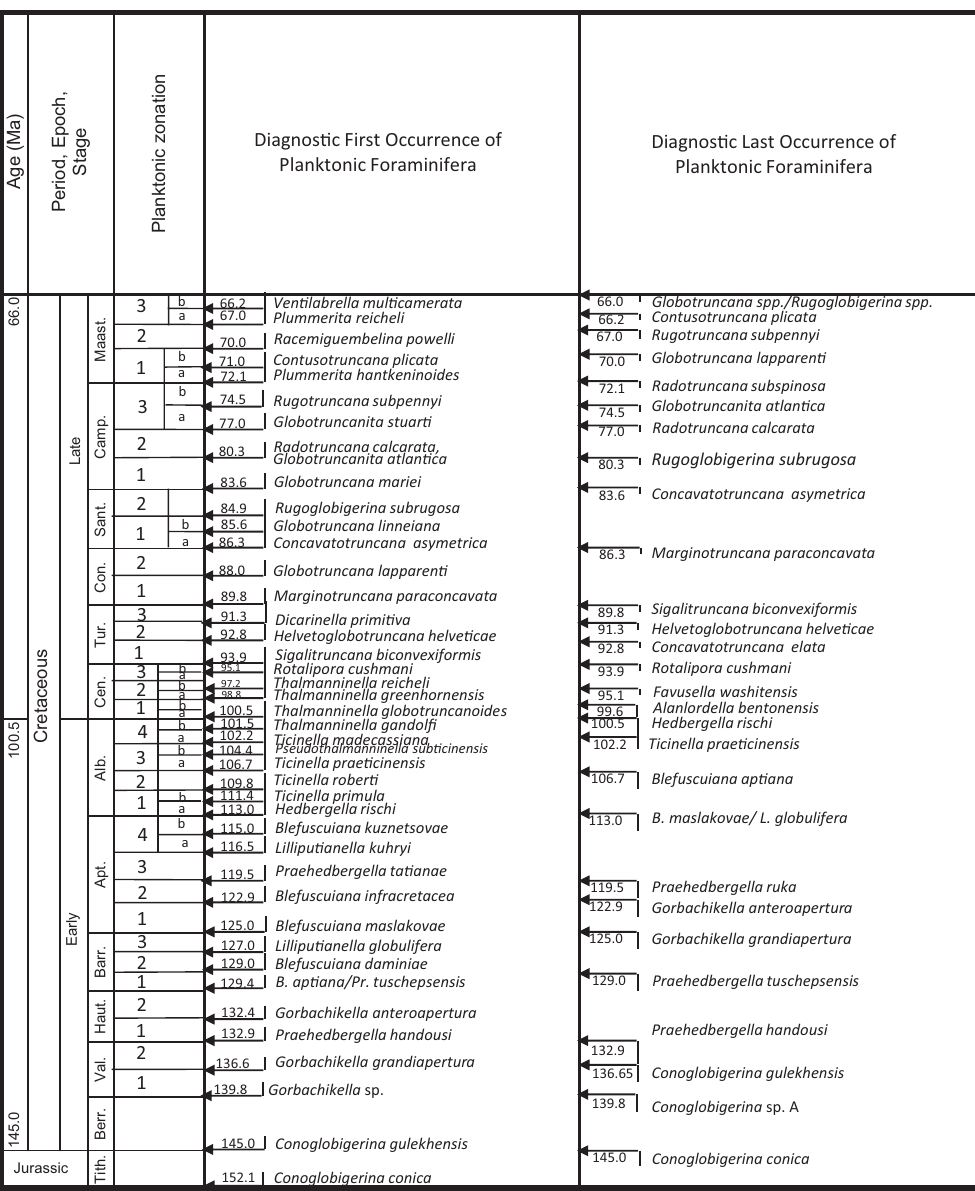
of the Meratus Mountains, an uplifted accretionary collision complex that records suturing of The diagnostic first and last occurrences of Cretaceous planktonic East Java–West Sulawesi to the Sundaland margin during the mid-Cretaceous (see Fig. 3). The foraminiferal species, calibrated against uplifted complex now forms the eastern boundary of the Barito Basin, South Kalimantan, Indonesia the most recent biostratigraphic time (see [60]). scale and radio-isotope data (after BouDagher-Fadel [2]). By correlating these observations and the literature data with our high-resolution PZ scheme ([2], Fig. 1), we are able to infer, for the first time, a comprehensive, global synthesis of the biostratigraphic, phylogenetic, and paleogeographic evolution of these orbitolinids. We infer that the earliest morphologically complex orbitolinids evolved in the Tethys from primitive Valanginian forms such as Valdanchella, Paleodictyoconus and Campanellula (Fig. 4). More complex forms developed rapidly into different Tethyan phylogenetic lineages (e.g. Figs 4 and 5). It appears that major, global sea level regressions starting in the early Aptian (PZ Aptian 1, 125.0 Ma) and in the late Aptian (PZ Aptian 4, 116.5 Ma; see Fig. 6), correlate with and probably facilitated bidirectional transoceanic migration of orbitolinids. One migration was from the Tethys to the previously recognised American province, but a second migration was from Tethys to the newly defined Western Pacific province (see Fig. 7). These migrations stopped after rising sea level during the early Albian (PZ Albian 1) appears to have isolated the provinces one from another.